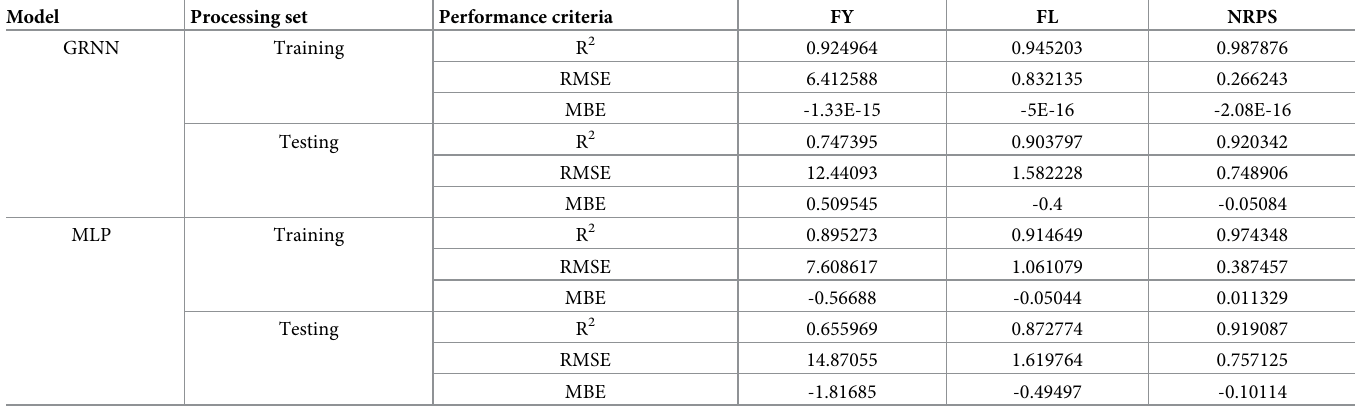
Table 2. Performance criteria of multilayer perceptron (MLP) and generalized regression neural network (GRNN) for fruit yield (FY), Fruit length (FL), and num- ber of rows per spike (NRPS) of greenhouse banana. Model Processing